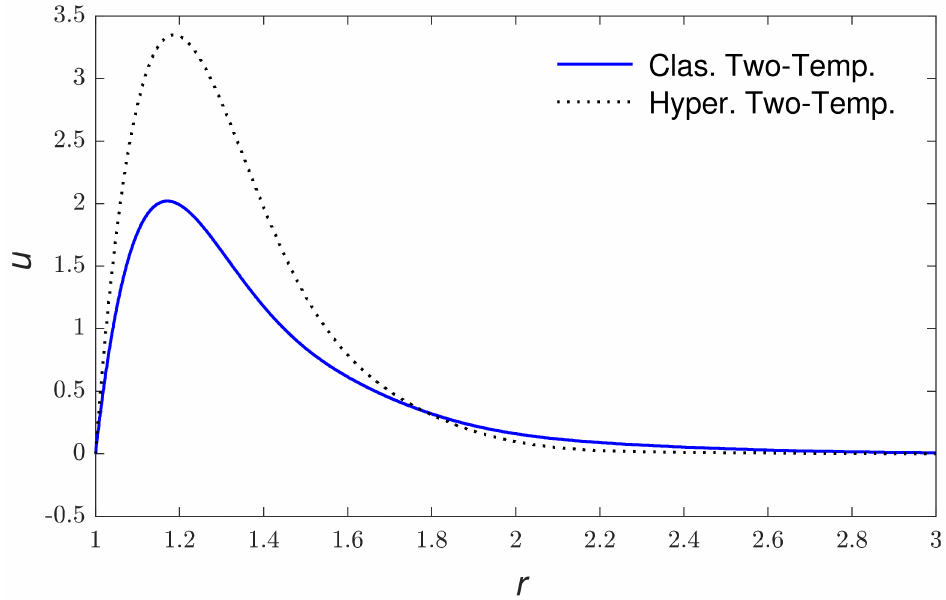
Figure 5. The displacement variations versus the redial